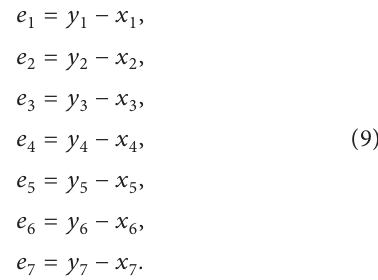
Figure 4: Time evolution of the vorticity at different times of one of the four laminar regimes at R e �